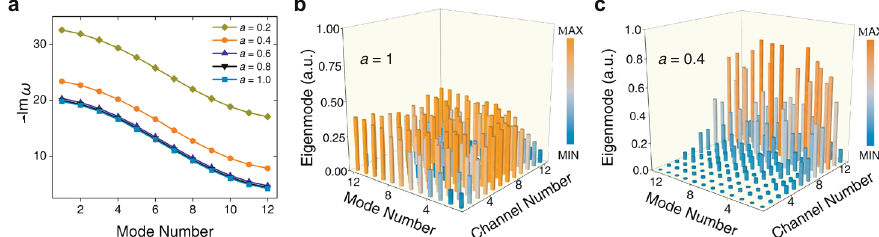
Fig. 4 Decay rates and eigenmodes. a Decay rates ð(cid:2) Im ω Þ at different asymmetric factors a . b Fields of all eigenmodes with the symmetric coupling a = 1. c Fields of all eigenmodes concentrate at the interfaces with the asymmetric coupling factor a = 0.4. COMMUNICATIONS PHYSICS| (2021) 4:230